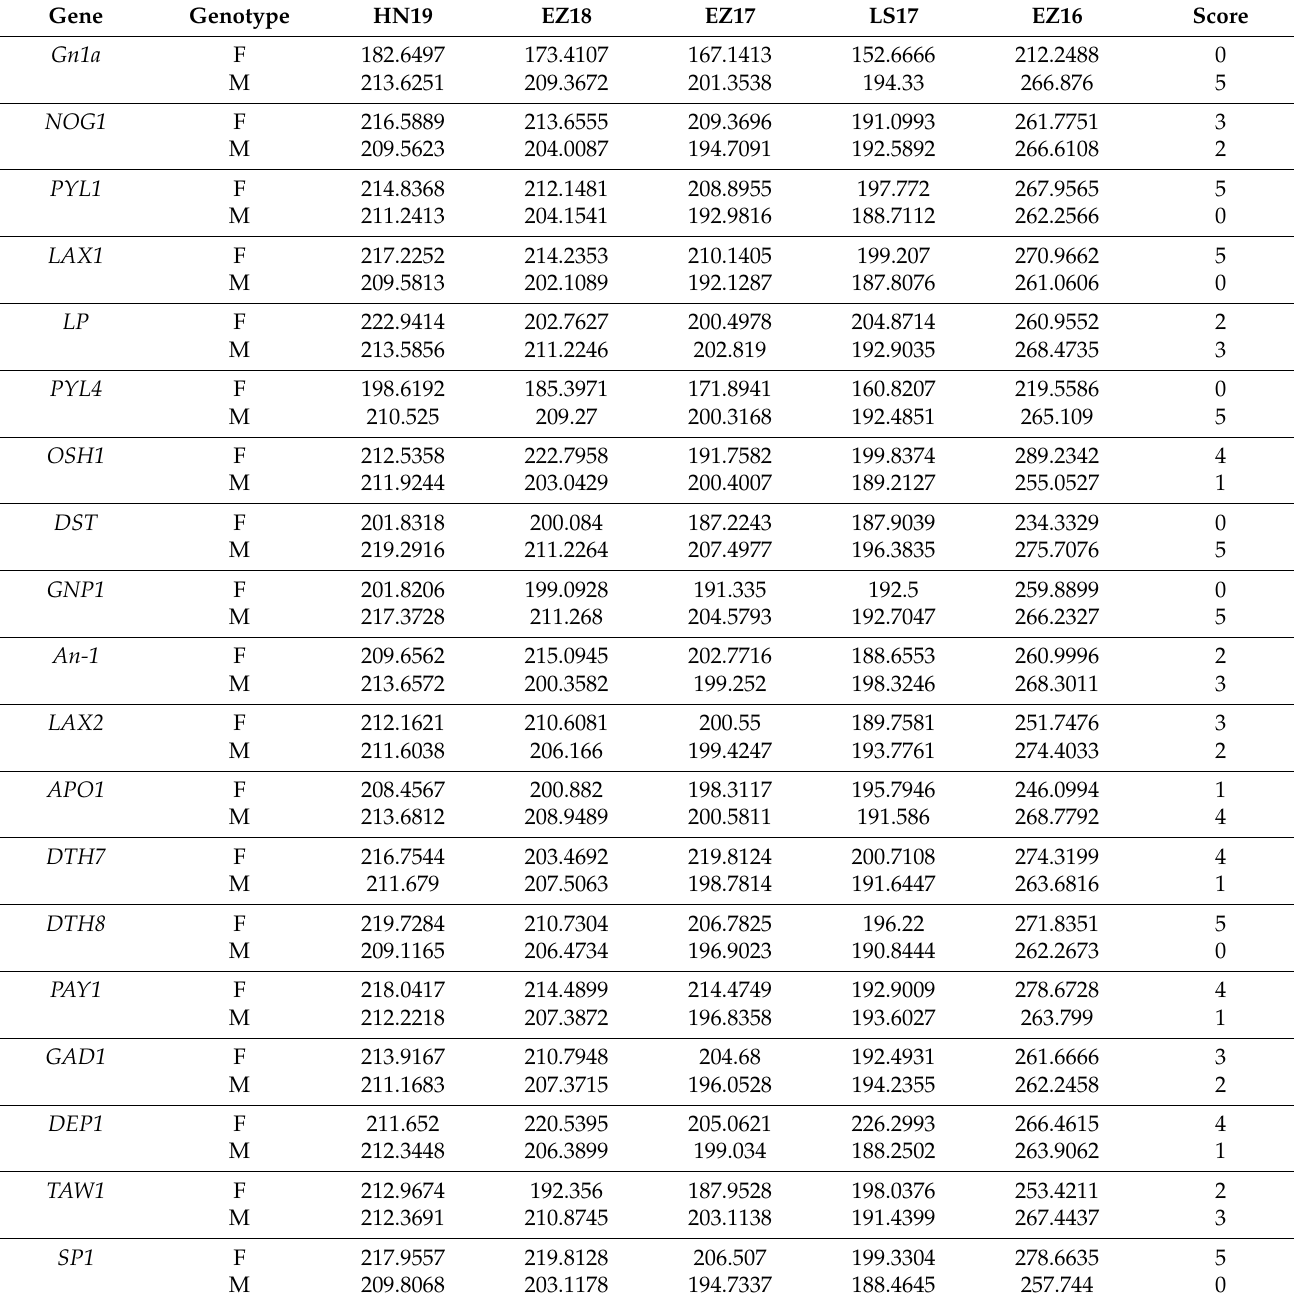
Table 2. Score of parental genotypes in the mean of grains number per panicle in five